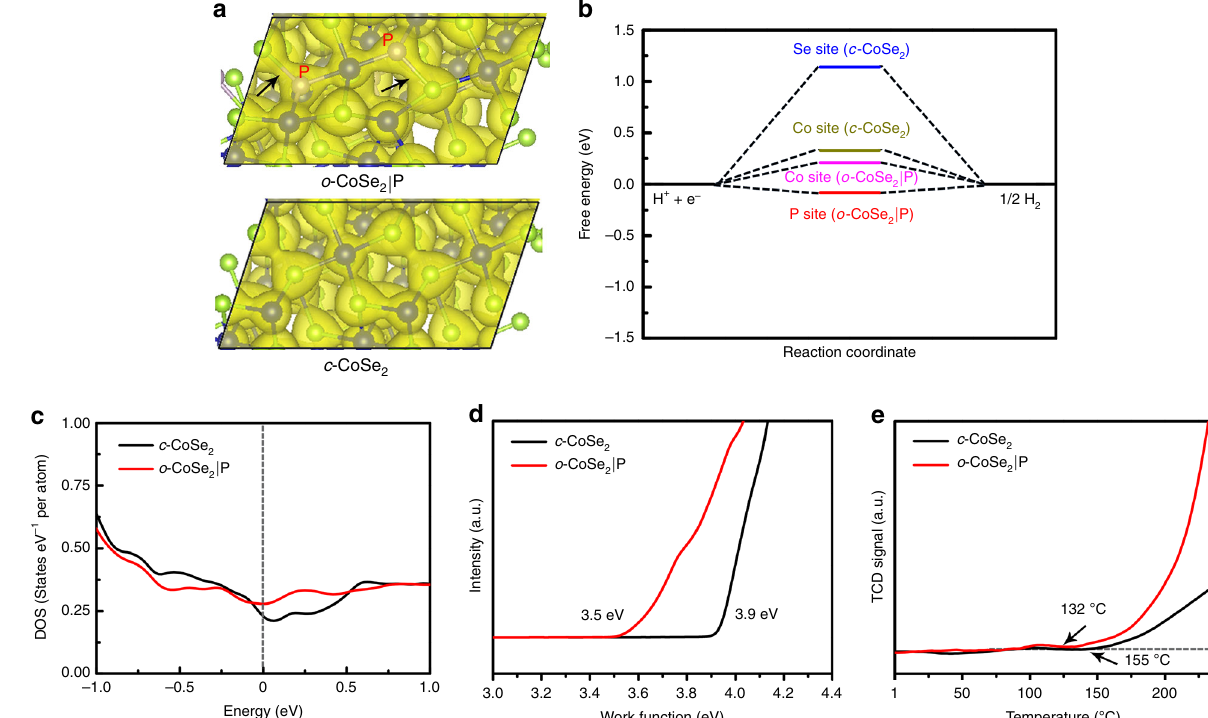
Fig. 5 DFT calculation and enhancement mechanism. a Calculated charge density distribution for o -CoSe 2 |P (up) and c- CoSe 2 (down) catalysts. b Free energy diagrams for hydrogen adsorption at different sits on the (111) surface of o -CoSe 2 |P (8 wt%) and c- CoSe 2 . c Calculated total densities of states of c- CoSe o -CoSe 2 and 2 |P with the Fermi level aligned at 0 eV. d , e Ultraviolet-photoelectron spectra and H 2 temperature-programmed desorption analyses for c- CoSe 2 and o -CoSe 2 |P catalysts,